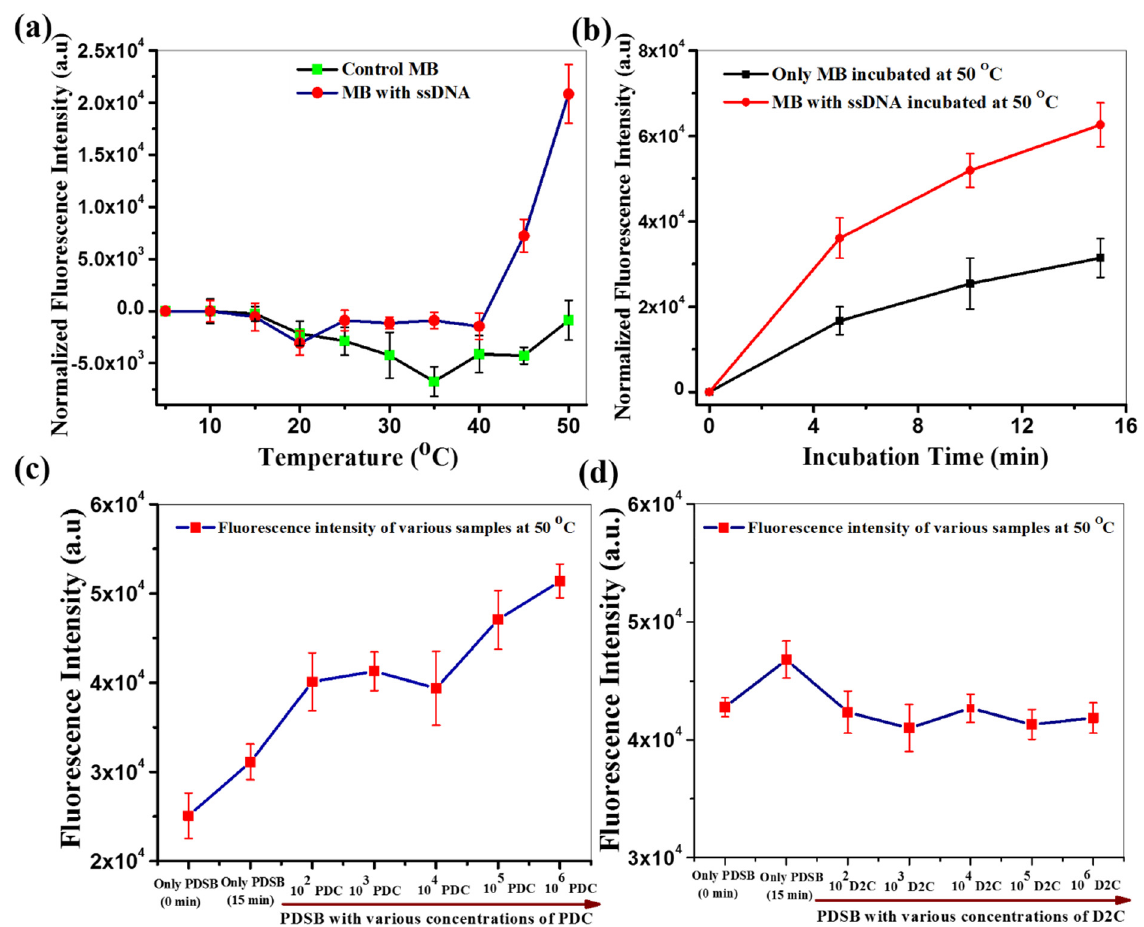
Figure 1. ( a – d ) Molecular beacon (MB) standardization ( a ) comparison of fluorescence intensity of molecular probe, in absence and presence of ssDNA with increasing temperature; ( b ) Relative fluorescence increment of MB and MB with ssDNA when incubated for different time periods at 50 °C; ( c ) PDSB probe was incubated with different concentrations of PDC target at 50 °C to check the sensitivity of PDSB probe; ( d ) PDSB probe was incubated with different concentrations of non-specific target (D2C) to check for the specificity of PDSB probe. Each experiment was performed thrice ( n = 3), and error bars represent the standard deviation of fluorescence intensity measurement from average value.